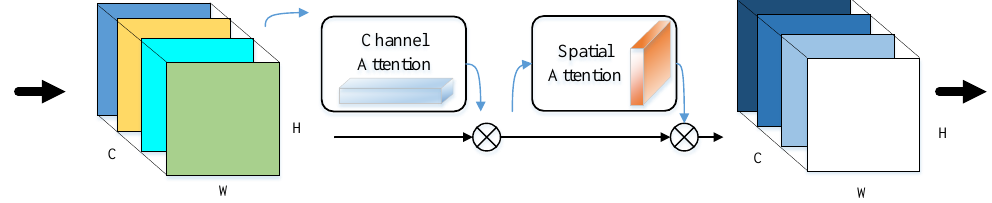
Figure 7. The basic structure of the CBAM. The channel attention module assesses the importance of each channel and gives the input channels the corresponding weights, and the spatial attention offers different attention to pixels in each channel according to the significance.